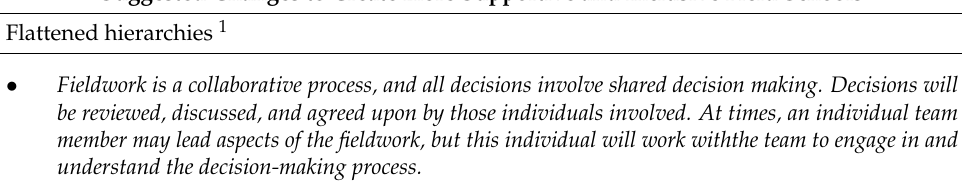
Table 2. Exemplar text for selected policy and language changes, adapted from